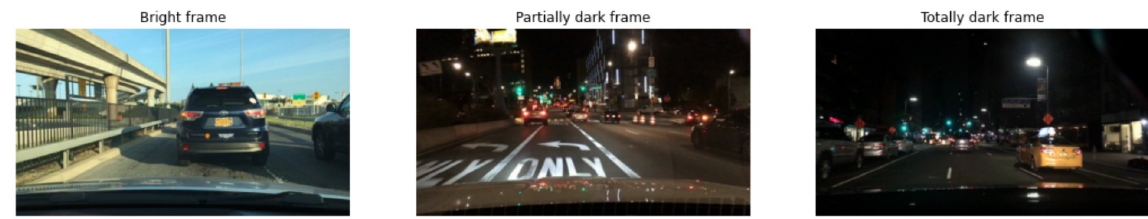
Fig 3. Examples of different lighting conditions in the BDD100K dataset.